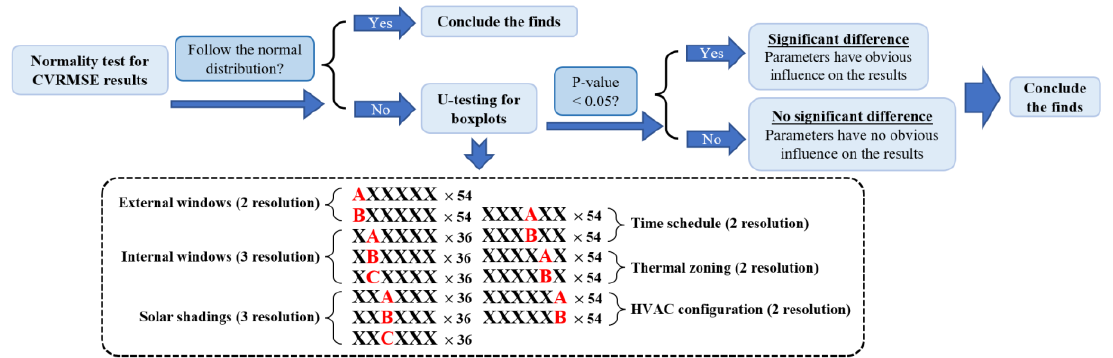
Figure 4. The sensitivity-analysis process of the model simulation results under the Morris-method framework.